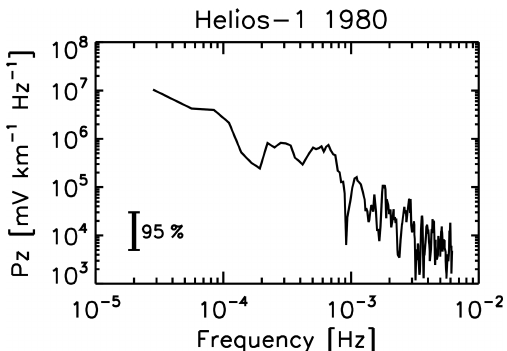
Figure 2. Frequency spectrum (in the spacecraft frame) of the out- of-ecliptic component (the z component) of electromotive force de- rived from the Helios-1 at a radial distance of 0.53 astronomical units, after the spectral data presented by Marsch and Tu (1992). The magnitude value of the electromotive force is plotted here.